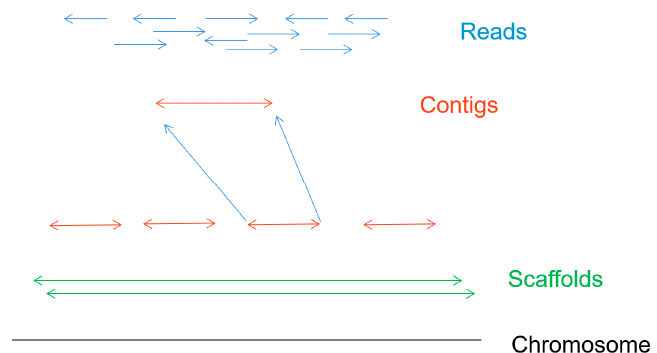
Figure 6. The process of assembly of chromosomes.